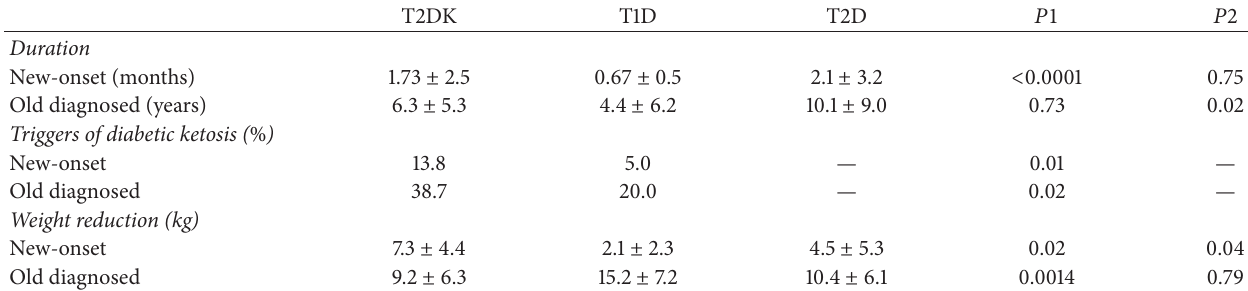
Table 2: Comparison of new-onset and old diagnosed diabetes.